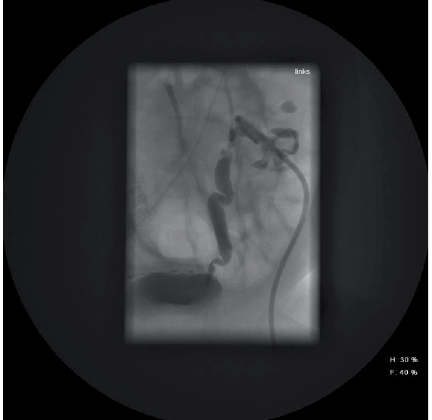
Figure 2 : Antegrade pyelography, left ureter wormed and segmentally dilated, residues of fungus balls in the collecting